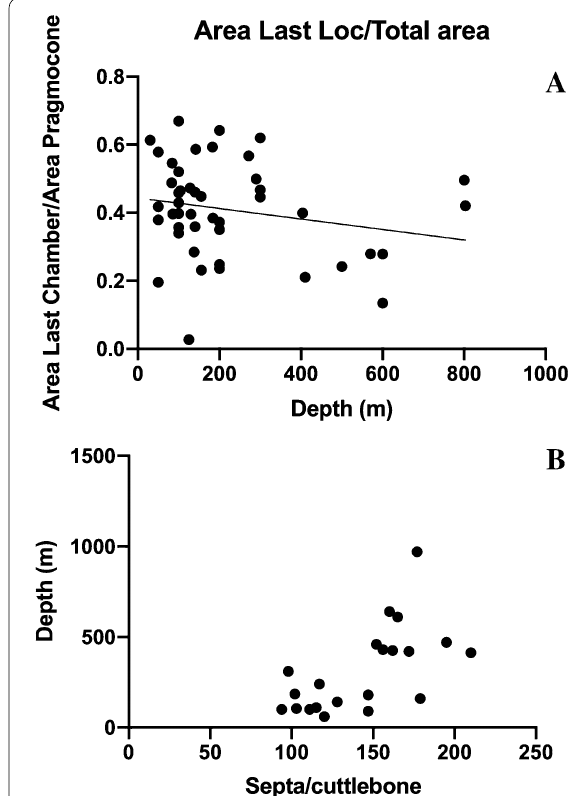
Fig. 11 Scatterplot of different morphometric relationships of Sepia spp. against depth. A Shows maximum depth plotted against number of septa/cuttlebone. The graph consistent with the hypothesis that deeper water species have cuttlebones with more septa/mm of length, with higher septal density interpreted as a pressure (depth) related adaptation. B Maximum depth of studies species, plotted against area of last loculus/total area of cuttlebone. While there is a large amount of scatter, it appears that the volume of the last loculus is reduced in deeper water-inhabiting species.